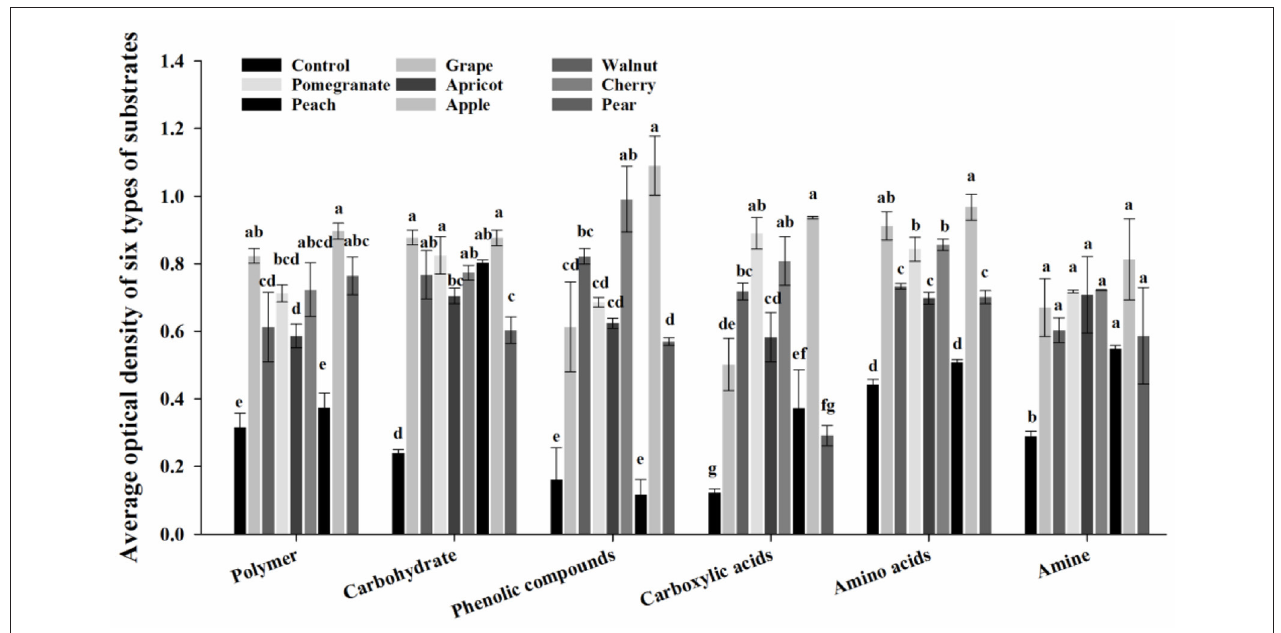
FIGURE 2 | Effect of different deciduous fruit trees on the rhizosphere microbial community utilization of six types of carbon substrates at 96h. Values are means ± SE, and letters denote significant differences among trees using one-way analysis of variance with tree species as the factor.